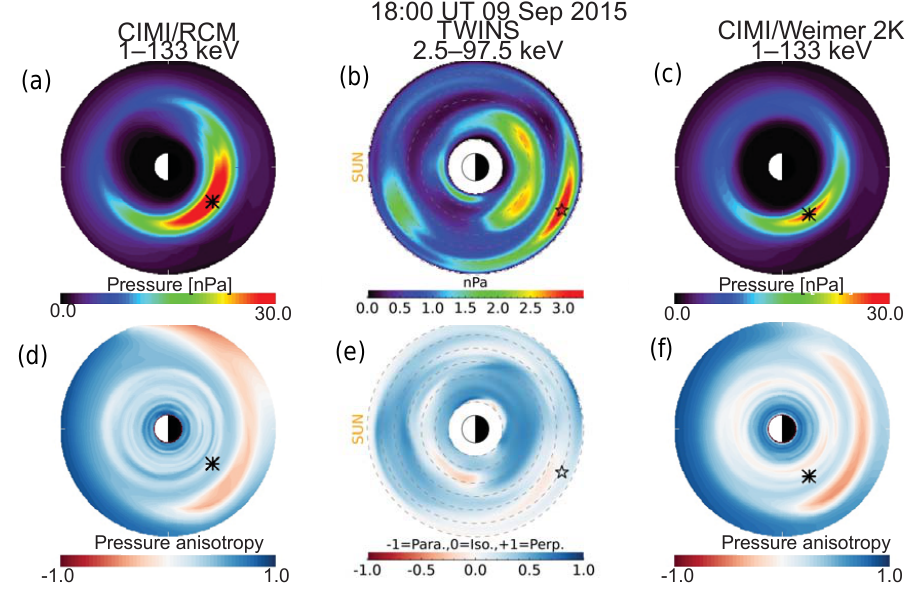
Figure 8. The ion equatorial pressure and pressure anisotropy for 18:00UT 9 September 2015 in the same format as Fig. 3.